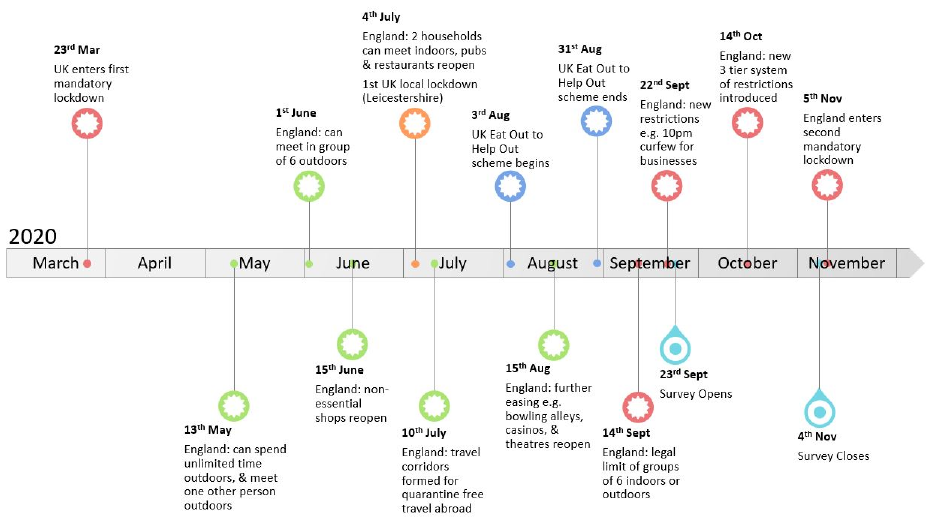
Figure 1. Summary of COVID-19 related restrictions and events in the UK, spanning the study